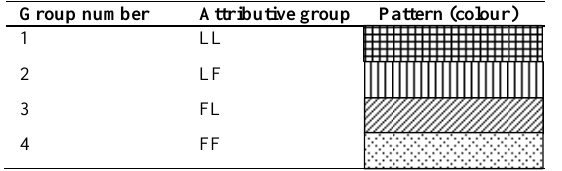
Table 4. Transcript for the pattern of attributive groups according to the level of sustainable development of the